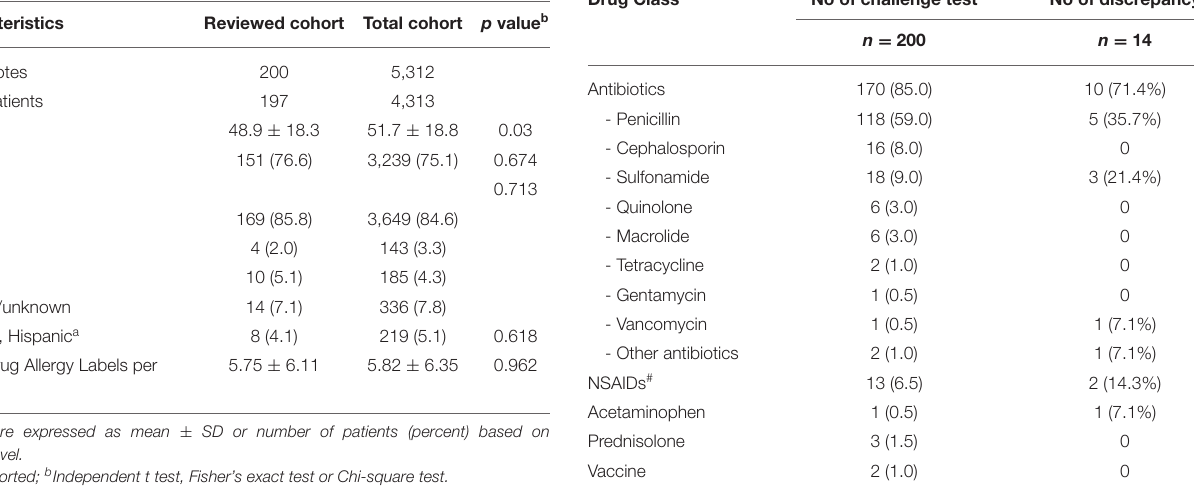
TABLE 2 | Descriptive statistics of reviewed challenge test by drug class.